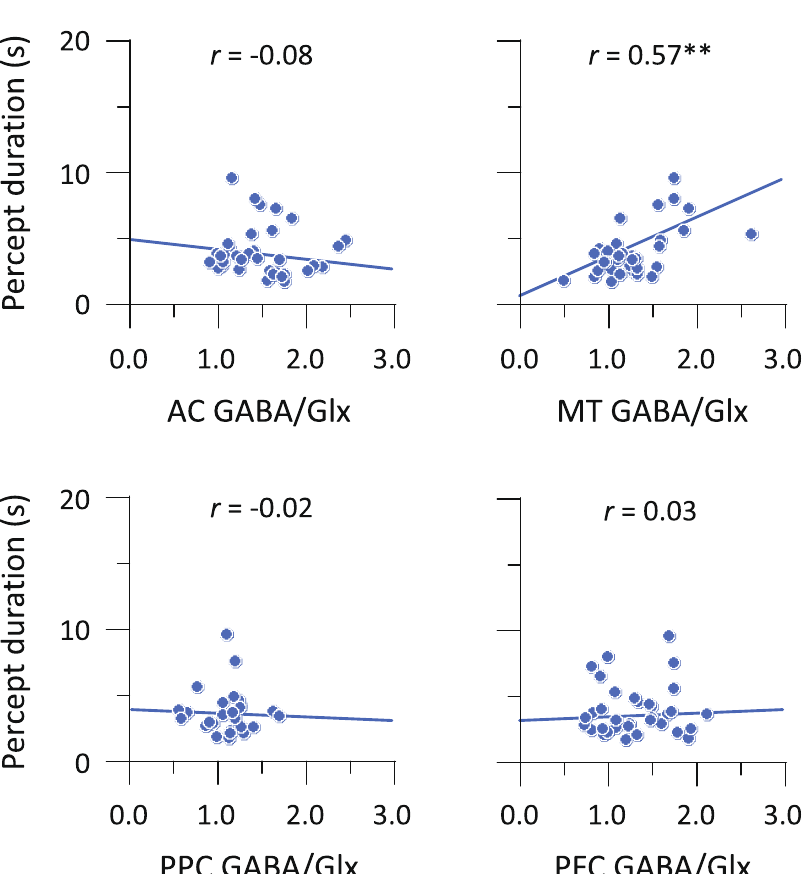
Figure 5. Correlations between MRS and behavioural results in moving plaids. Scatter plots with linear regression fit for the relationship between GABA/Glx ratios and median percept durations. Circles indicate individual data under the Neutral conditions. ** p <